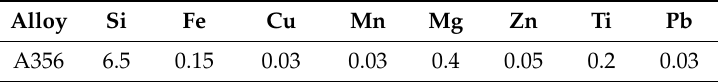
Table 1. Chemical composition of the A356